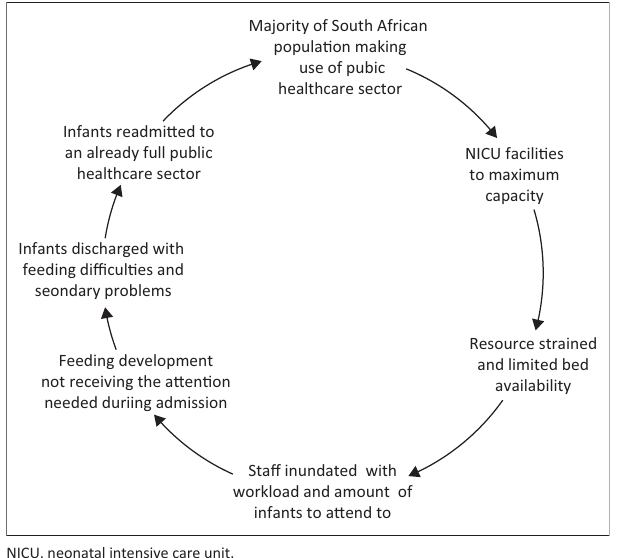
FIGURE 3: Feeding challenges within the neonatal intensive care unit prior to